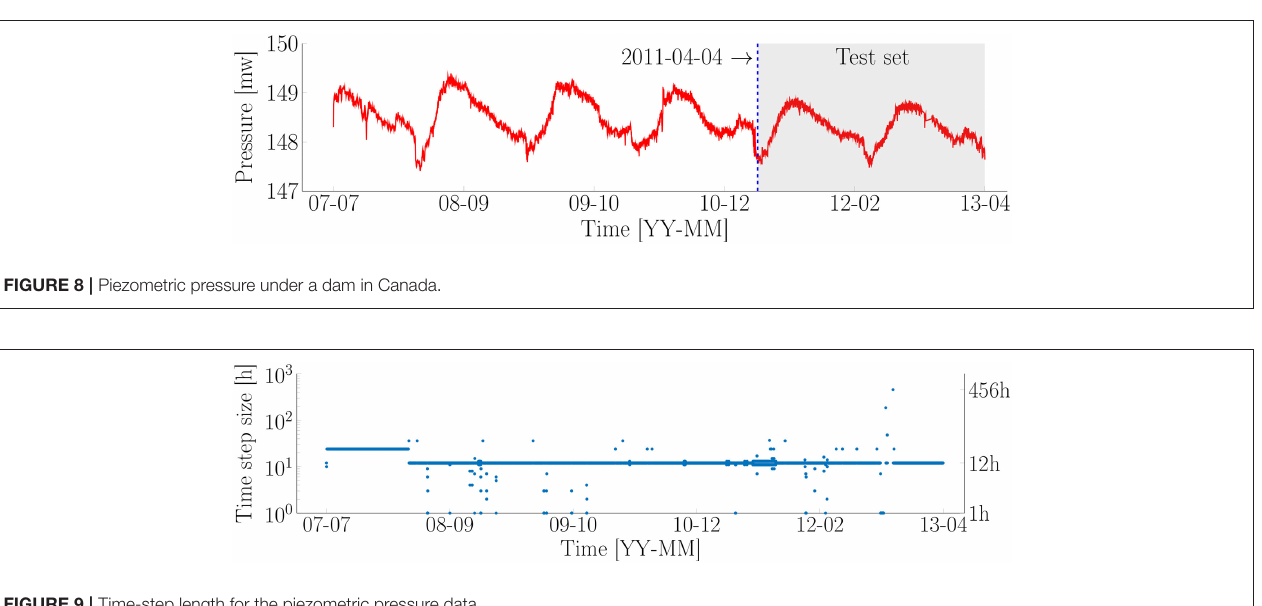
FIGURE 9 | Time-step length for the piezometric pressure data.